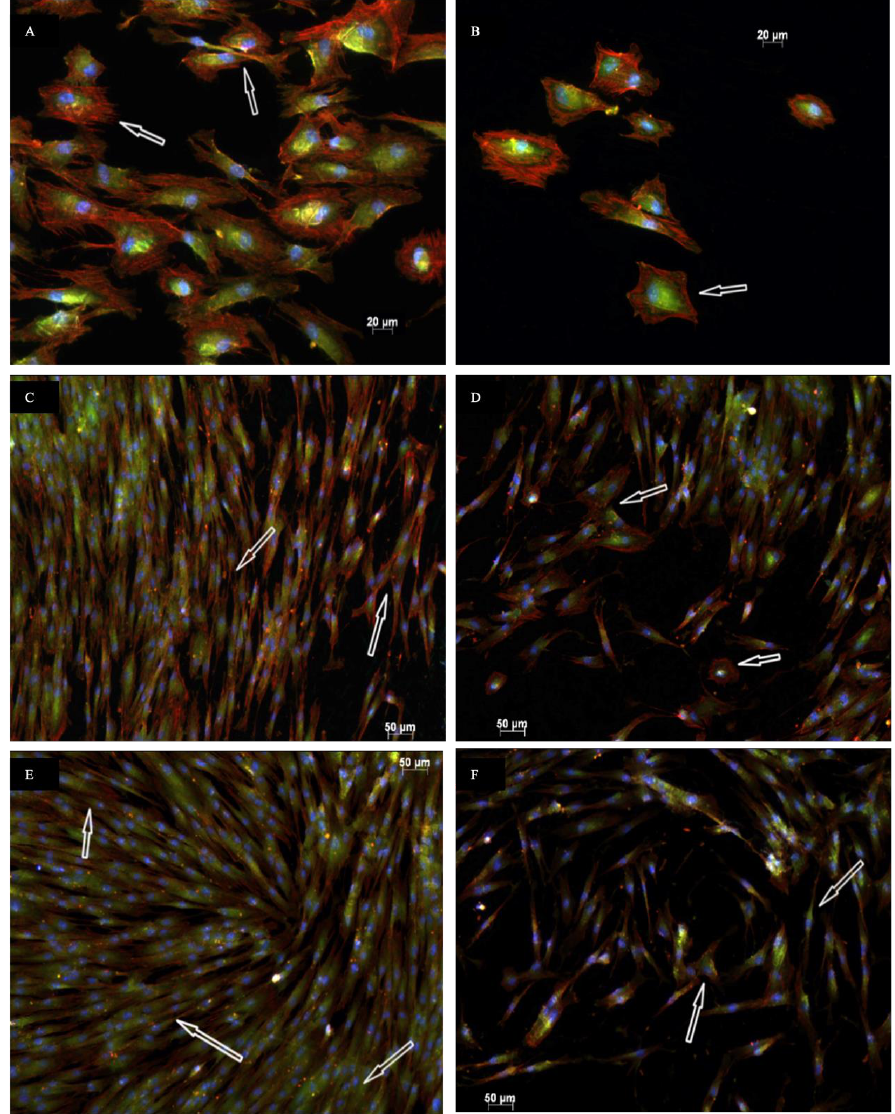
Figure 1. Representative fluorescence microscopic images of fibroblasts on machined titanium discs after 4, 12 and 24 h of cultivation (Vinculin, Phalloidin, DAPI stains). ( A ) Plasma-treated sample after 4 h of culture. Cells show planar attachment of the individual cells (arrow: green staining, vinculin). ( B ) Control sample, after 4 h of culture with rounded cell bodies (arrow) with small areas of adhesion (green). ( C ) Treated sample after 12 h of culture. Arrows: elongated cells with intensive attachment and cell interaction (green). ( D ) Control sample, after 12 h. Arrows: more round cells are present and less attachment (green). ( E ) Treated sample after 24 h. Arrow: intensive attachment of cells, elongated configuration. ( F ) Control sample after 24 h of culture. Arrow: less cells and lower focal attachment (green) of the individual fibroblasts in comparison to the treated samples ( E